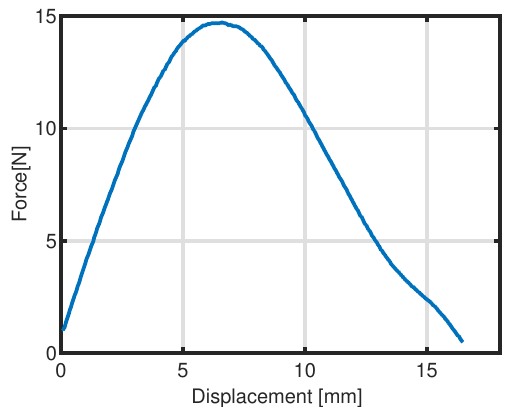
Figure 9. Force needed for the transition between one stable state and the other one in the hybrid soft mechanism based on Von Mises elastic